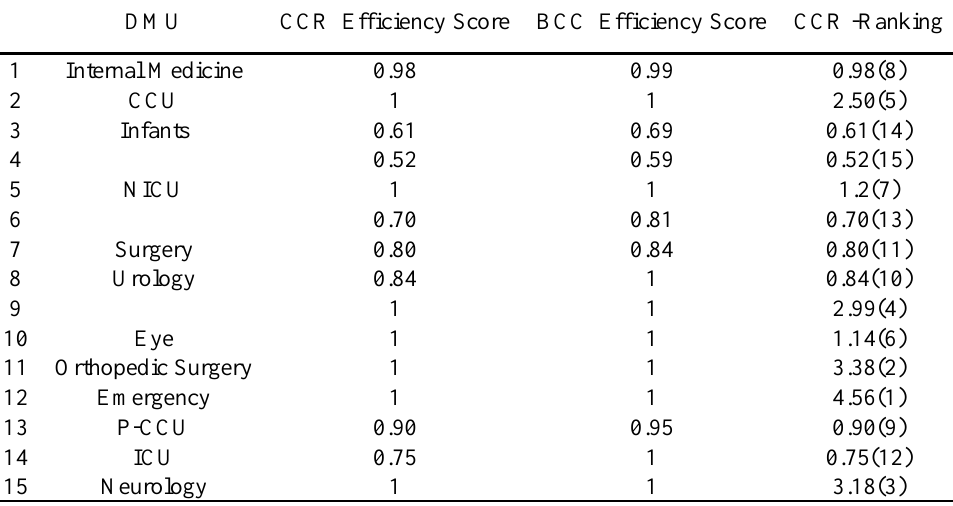
Table 7. Efficiency score and ranking in case study application in year 1396.